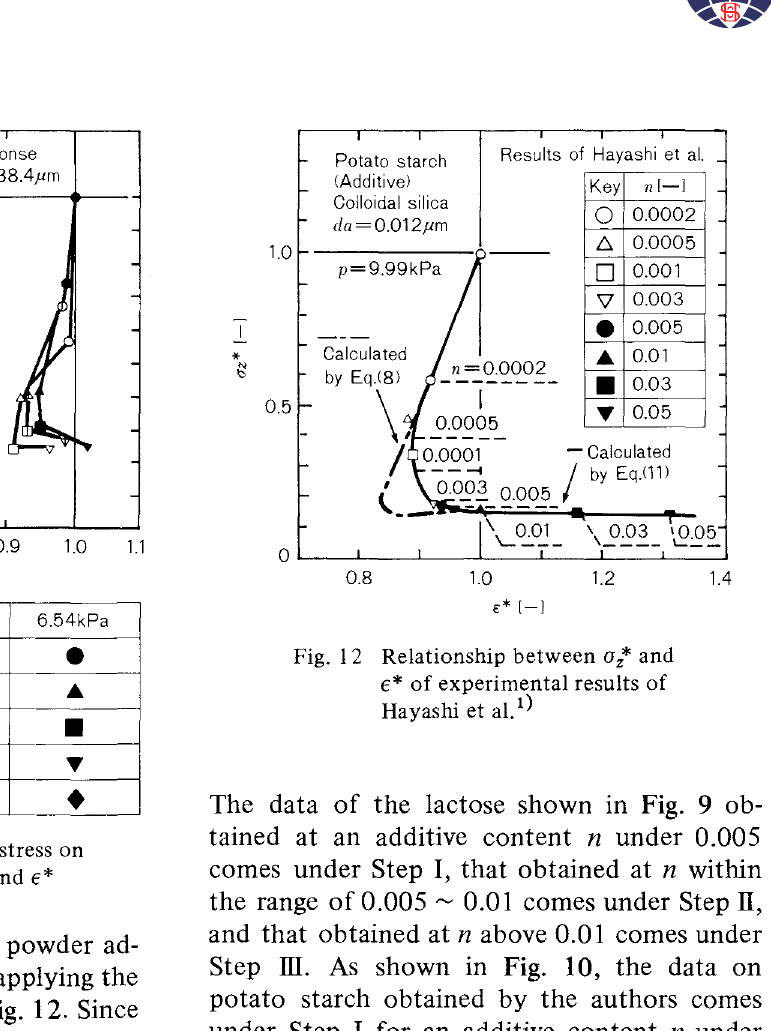
Fig. 12 Relationship between az* and E* of experimental results of Hayashi et al. 1 )